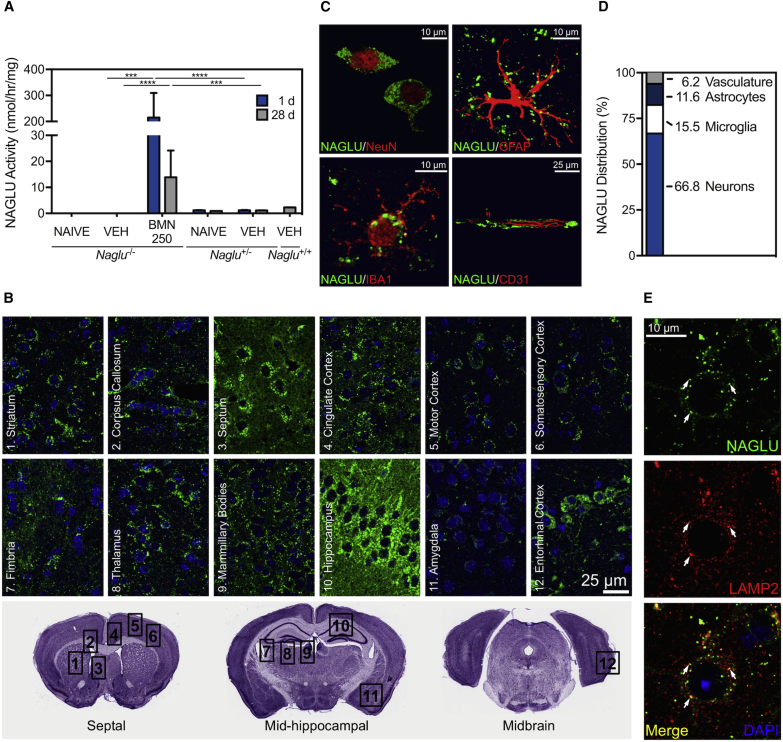
Uptake and Biodistribution of BMN 250 in Naglu−/− Mouse BrainNaglu−/− mice were administered 100 μg ICV doses of BMN 250 or vehicle (controls) on study days 1, 5, 10, and 14. n = 6–8 animals per treatment group, except n = 2 for the naive Naglu+/− group. (A) NAGLU enzyme activity (mean ± SEM) measured in brain homogenate 1 or 28 days after the last ICV infusion. VEH, vehicle. ***p < 0.001, ****p < 0.0001. (B) Immunohistochemical signal of NAGLU (green) with DAPI nuclear stain (blue) in the septal, mid-hippocampal, and midbrain sections, showing bilateral biodistribution across the neuro-axis 1 day after the last ICV dose. (C) Representative high-resolution confocal images of NAGLU (green) co-stained with NeuN, GFAP, IBA1, and CD31 (red), showing localization of the NAGLU signal to neurons, astrocytes, microglia, and endothelia, respectively, 1 day after the last ICV infusion. (D) Percent of total NAGLU signal associated with each cell type, determined by quantitative analysis on co-stained sections 1 day after the last ICV infusion. (E) Representative high-resolution confocal images of NAGLU (green) co-immunostained with LAMP2 (red), showing localization of the NAGLU signal to lysosomes (yellow), indicated by arrows, 1 day after the last ICV infusion.